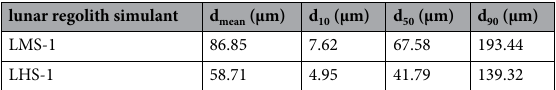
Table 2. Particle size distribution characterization values.